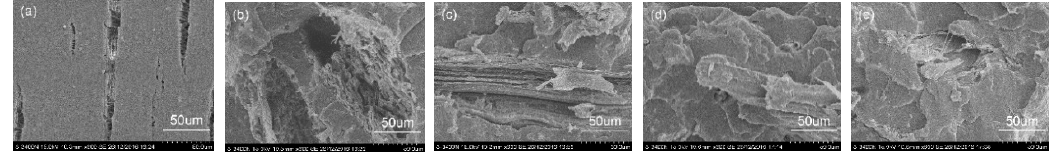
Figure 11. SEM images of fracture surfaces of PLA/BF composites: ( a ) PLA, ( b ) PLA/UBF, ( c ) PLA/ABF, ( d ) PLA/SBF, ( e ) PLA/ASBF. ( d ) PLA / SBF, ( e ) PLA /